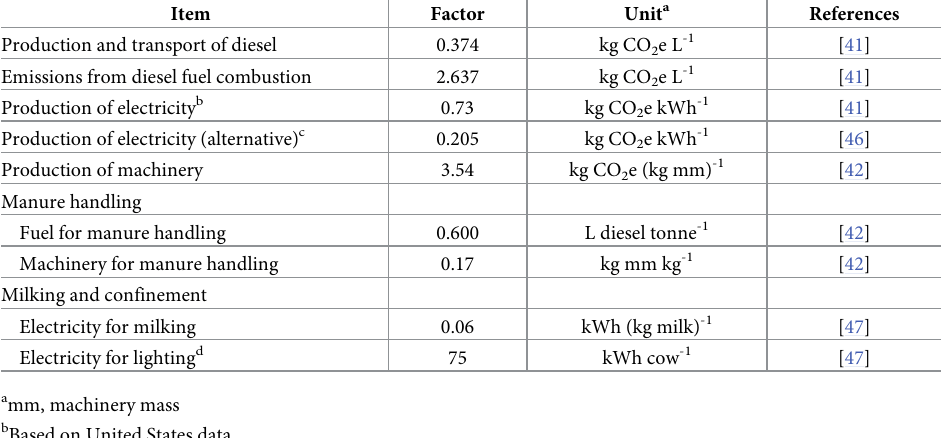
Table 5. Factors for major resource inputs in farm management.